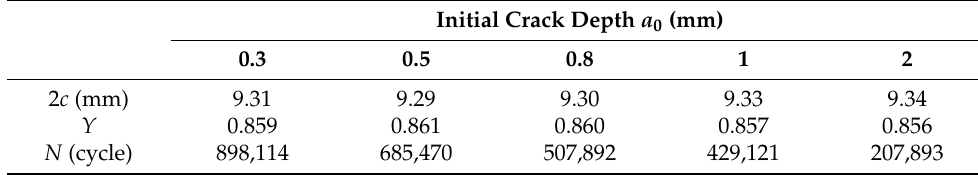
Table 4. Fatigue life of conical-cylindrical shell with different initial depths.